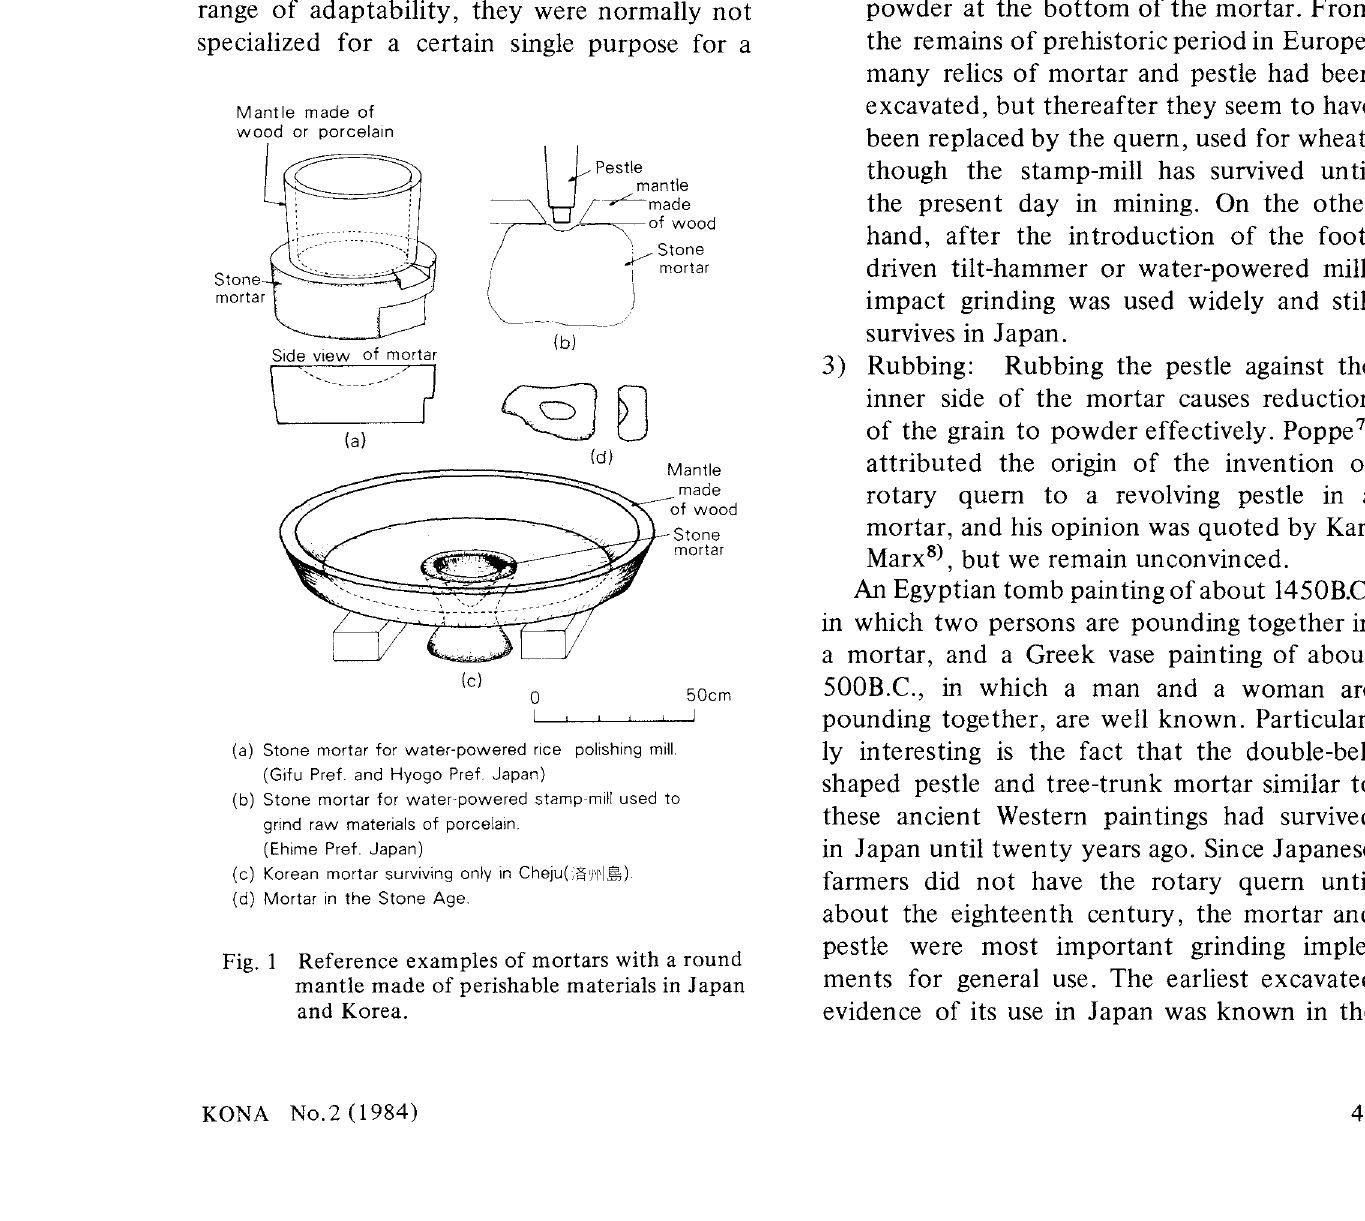
Fig. 1 Reference examples of mortars with a round mantle made of perishable materials in Japan and